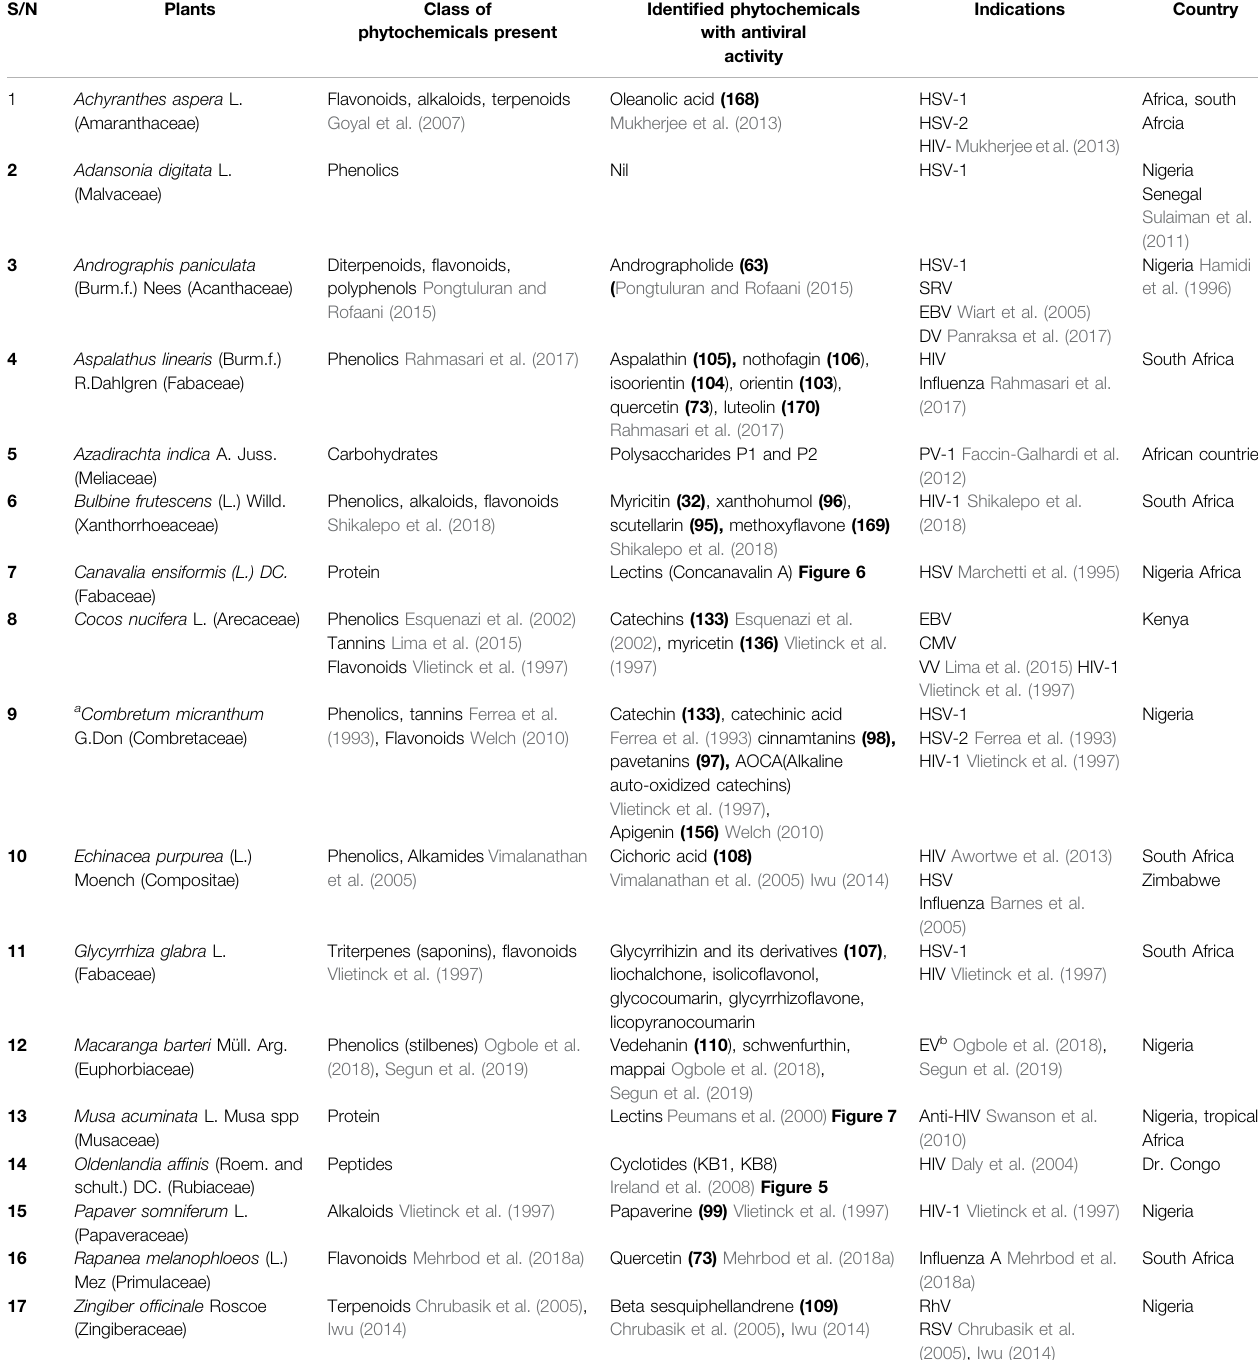
TABLE 1 | Selected antiviral Angiosperm plants of African origin and the major class of phytochemicals present based on widespread use and documented evidence.